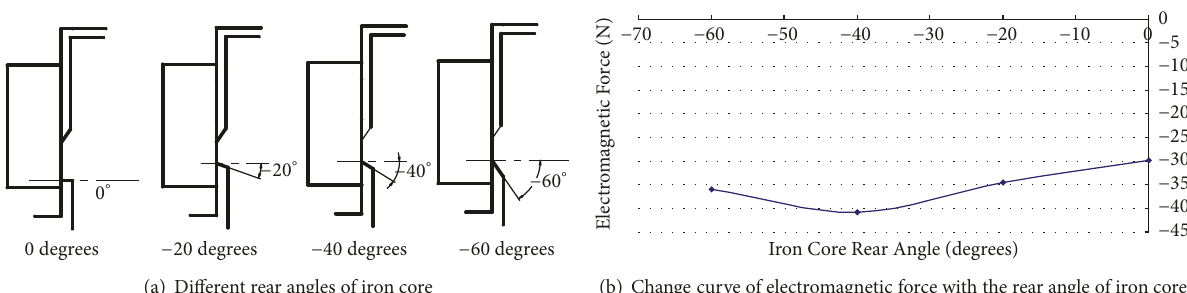
Figure 7: Different rear angles of iron core and the effect on electromagnet